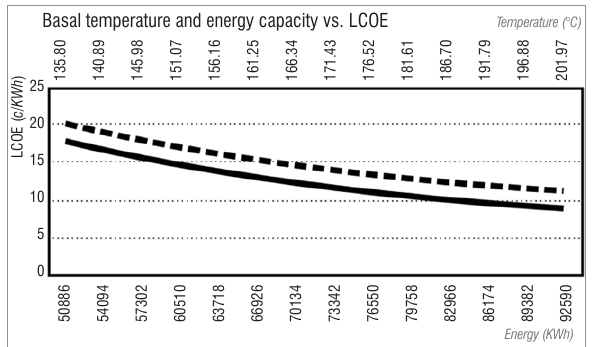
Figure 7: Graph illustrating the effect of an increasing basal reservoir temperature and consequential energy capacity on the levelised cost of electricity (LCOE). The dashed curve represents a scenario excluding a renewable energy feed-in tariff (REFIT), while the solid curve includes a USD25/MWh